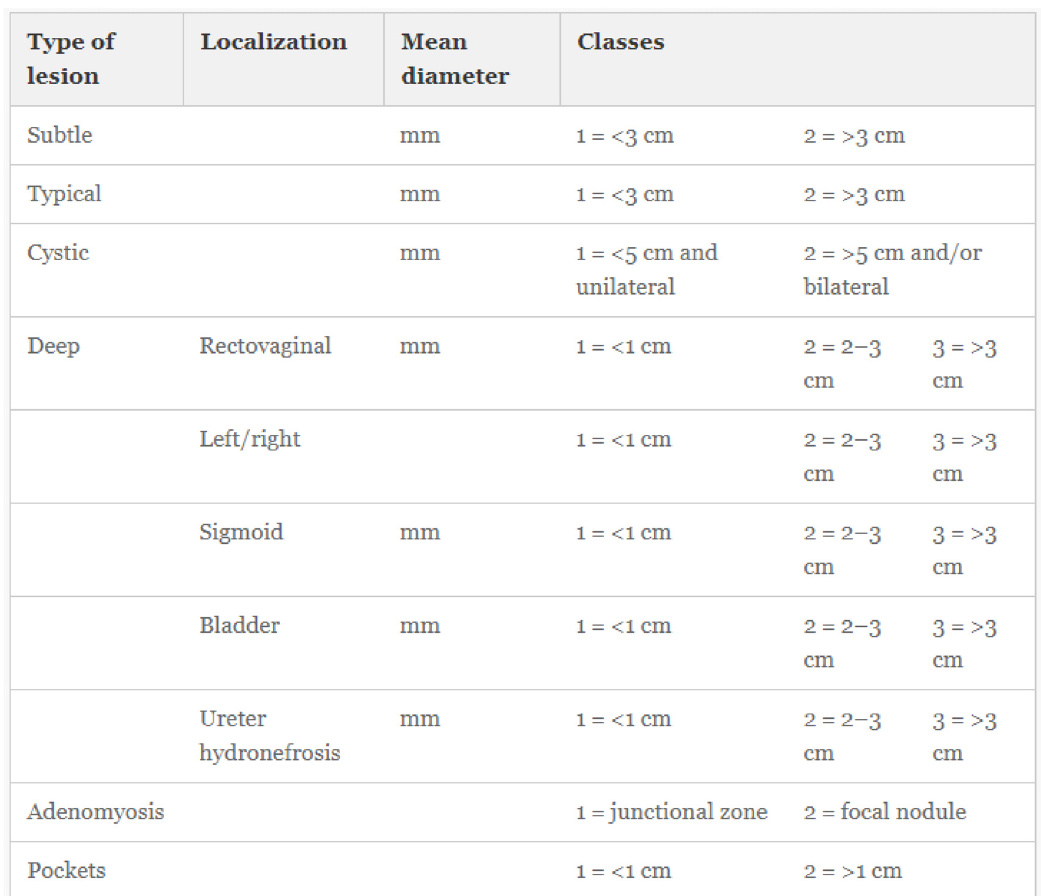
Figure 5. A new proposal by Koninckx and Wattiez et al . 54